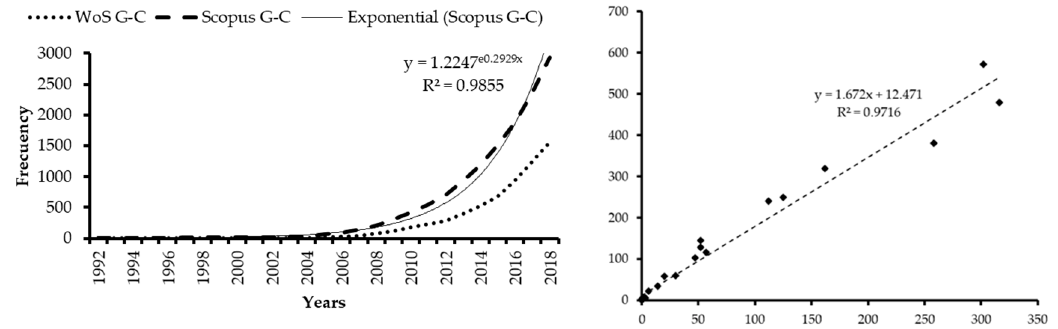
Figure 3. Citations: Growth and Correlation citations received for years. Source: own elaboration.